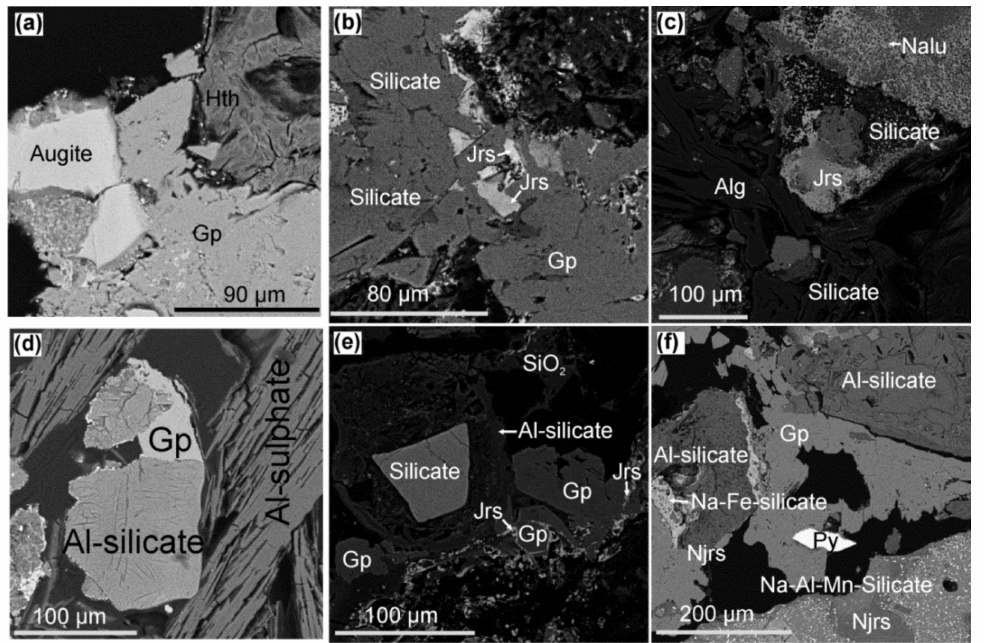
Figure 4. BSE images of efflorescent samples from Donnoe fumarole field: ( a ) halotrichite with gypsum, ( b ) jarosite with gypsum, ( c ) jarosite, natroalunite and alunogen, ( d ) gypsum with Al-silicate and Al-sulphate, ( e ) jarosite with gypsum and ( f ) natrojarosite with gypsum. Jrs—jarosite; Njrs— natrojarosite; Py—pyrite; Alg—alunogen; Gp—gypsum; Nalu—natroalunite, Hth—halotrichite. In samples from the Dachnoe thermal field, we found three baryte grains with sizes of 30–40 × 20 µ m. Trace amounts of Sr and Mg were found in the composition of baryte as 0.03 and 0.01 apfu , respectively (Table 2). Baryte was found in association with Al-sulphates identified as